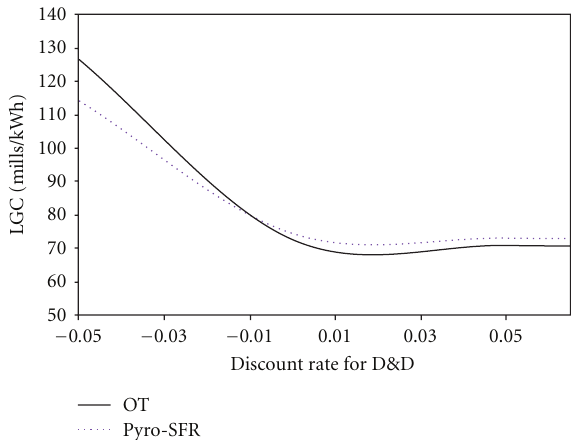
Figure 14: LGC dependent on discount rate for D&D.